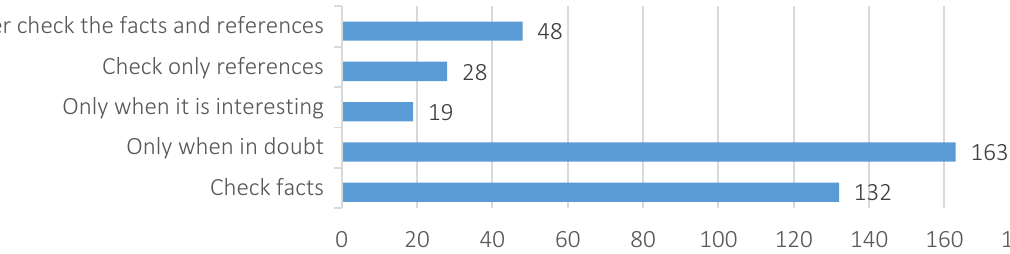
Figure 5. Distribution of answers to the question “Do you check the facts in scientific articles?”